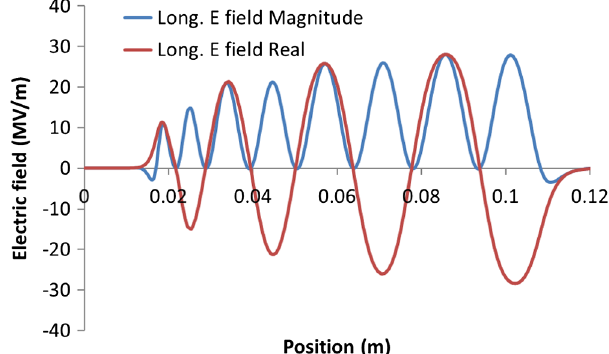
FIG. 7. Plot of the magnitude of the longitudinal electric field on axis in the cavity and the synchronous field seen by the electron